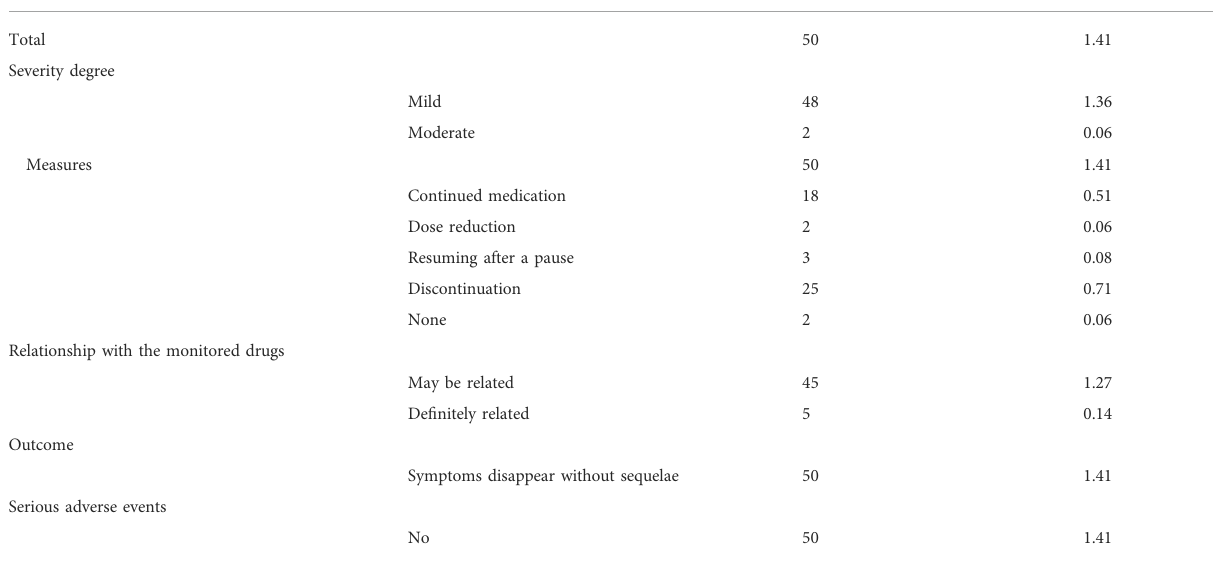
TABLE 4 Summary of adverse drug reactions in the